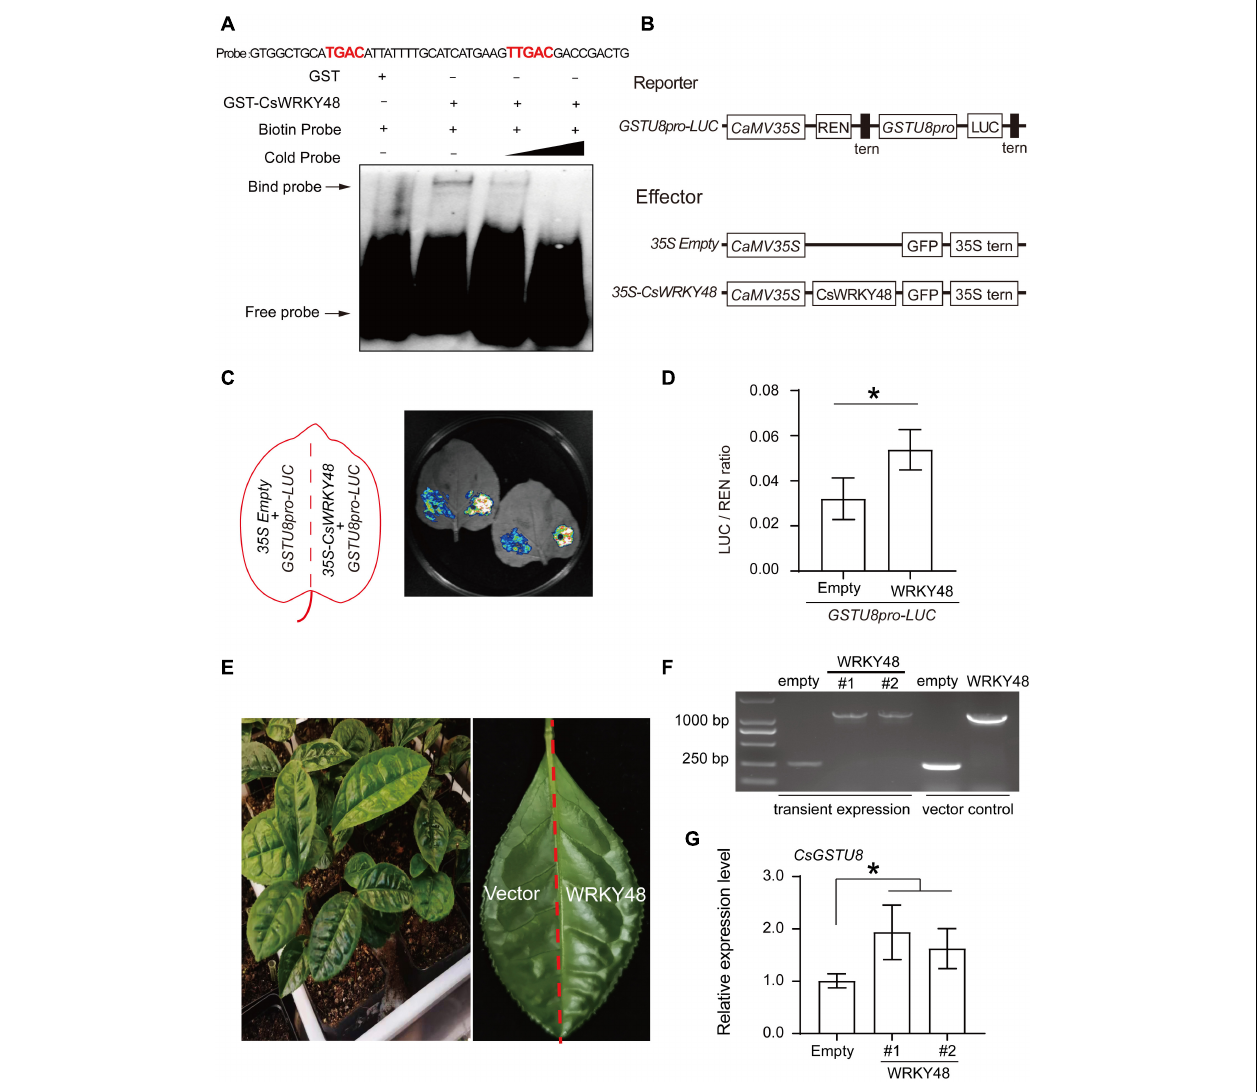
FIGURE 6 | CsWRKY48 binds to the promoter of CsGSTU8 and activates its expression. (A) EMSAs using purified GST and GST-CsWRKY48 proteins incubated together with biotin-labeled probes of W-box core elements (TGAC sequences) presented in CsGSTU8 promoter. -: absence; +: presence. (B) Schematics of the reporter and effector constructs used in the dual-LUC assays. (C) LUC signal detected in tobacco leaves. (D) LUC/REN ratio, as measured by the dual-LUC assays. (E) Transient expression of 35S::CsWRKY48-GFP and 35S::GFP in tea plant leaves. (F) RT-PCR was used to identify the transformation of 35S::CsWRKY48-GFP and 35S::GFP by using specific primers. (G) Expression of CsGSTU8 in transformed tea plant leaves. The data are presented as the means ± SDs of three independent experiments. Significant differences were determined using Student’s t -test (* P <